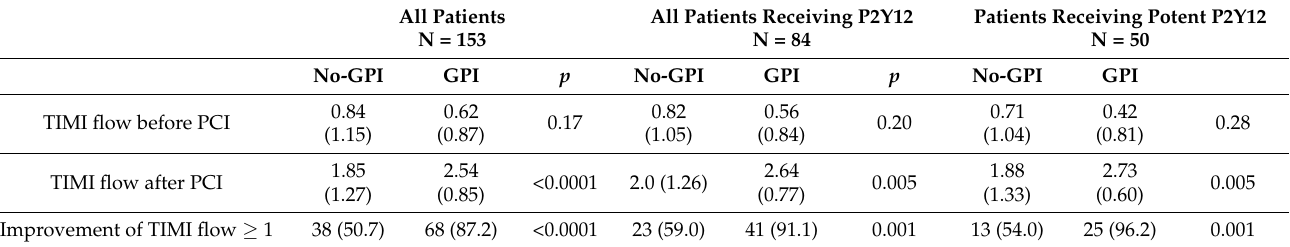
Table 3. TIMI grade flow before and after